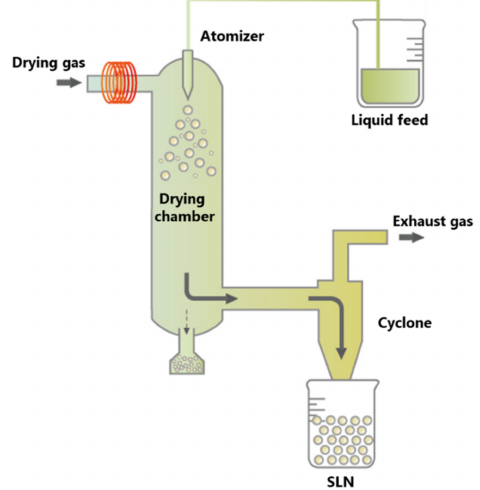
Figure 12. The procedure of spray drying